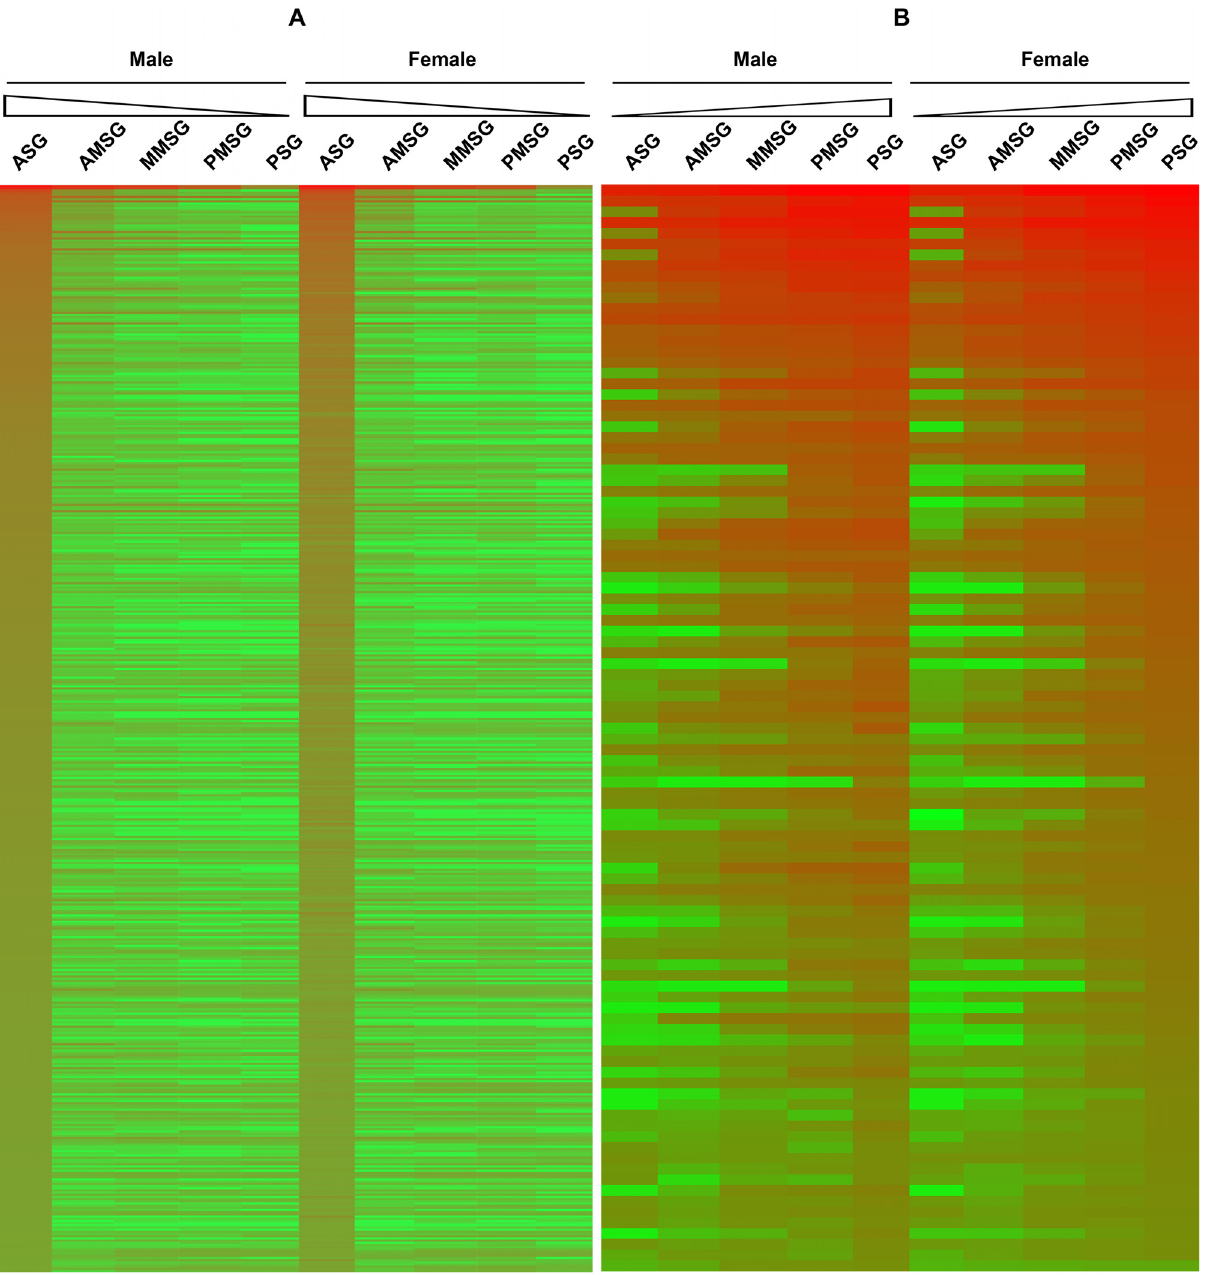
Fig 2. Gene expression gradient of the five silk gland sections. (A) Gene gradient of the 498 genes descending from the ASG to the PSG. (B) The 101 expressed genes crescent from the ASG to the PSG. The red bands indicate genes with high expression levels and the green bands indicate genes with low expression